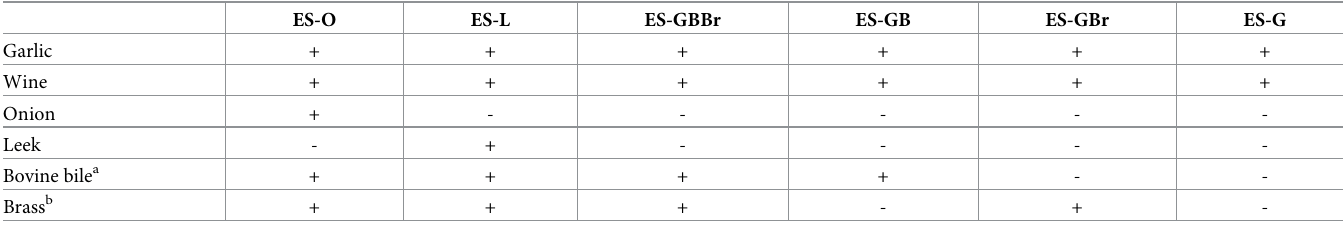
Table 1. Composition of Bald’s eyesalve (ES) formulations.